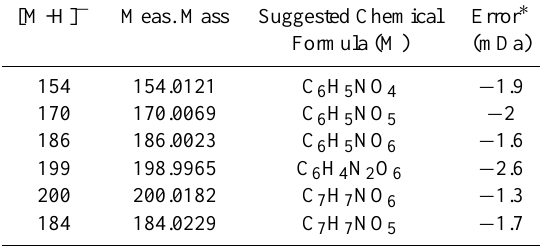
Table A2. SOA products observed in UPLC/(-)ESI-ToFMS offline filter analysis for the guaiacol high-NO x system. [M-H] − Meas.